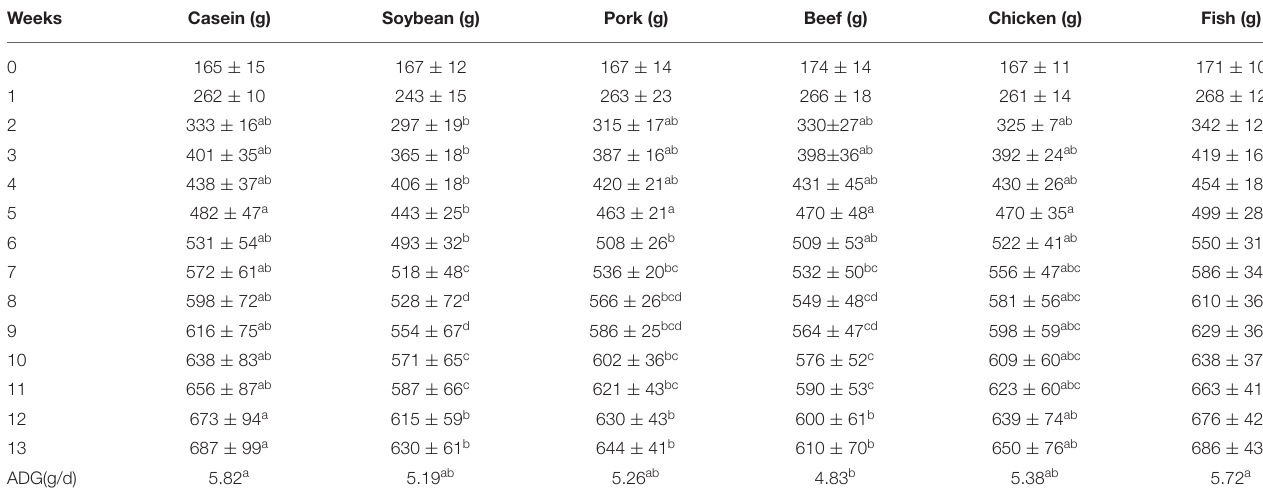
TABLE 3 | Effect of different proteins diets on body weight in rats ( n = 10). Weeks Casein (g) Soybean (g) Pork (g) Beef (g) Chicken (g) Fish (g) 0 165 ±